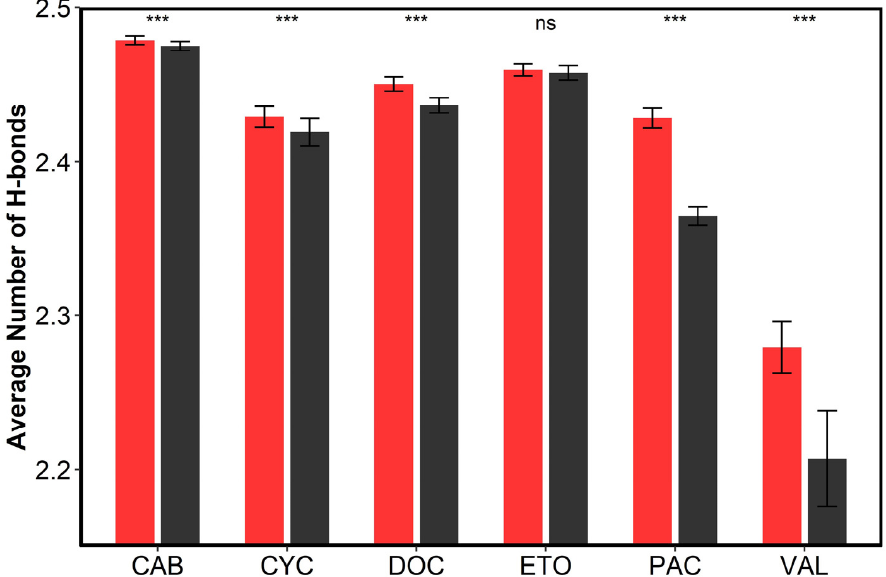
Figure 6. The number of hydrogen bonds between water − water (per water) in formulations without cosolvents (red column) and the formulations containing cosolvents (black column). Error bars are plotted as ± SD. The symbol “***” represents statistical significance with p < 0.001, and the symbol “ns” represents no statistical significance.